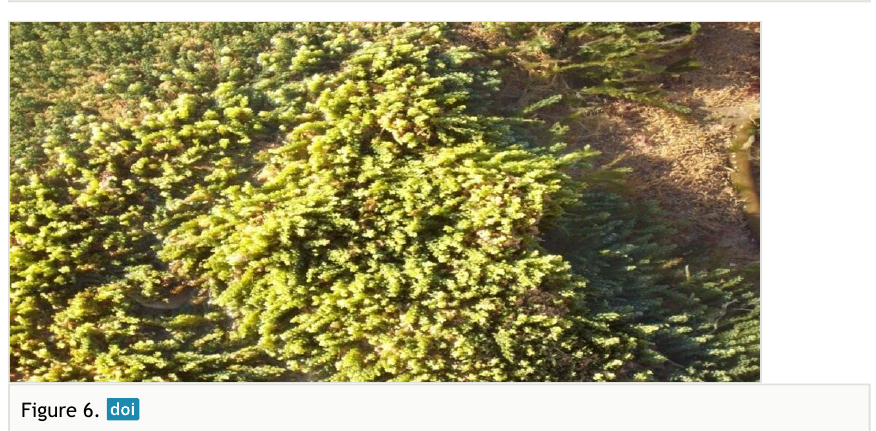
Dense colonies of Caulerpa cylindracea in the heavily affected station of